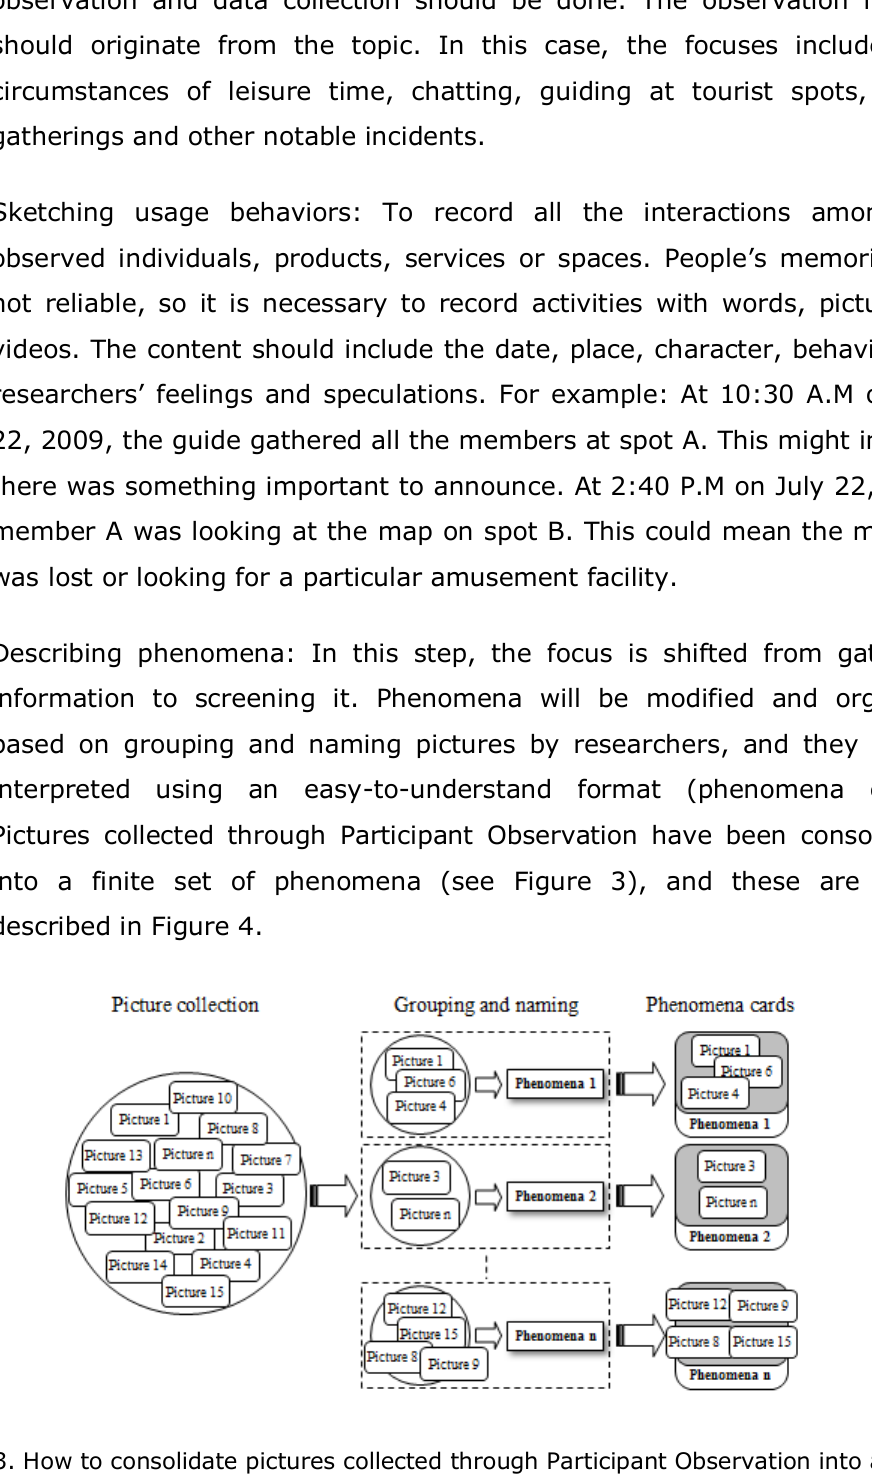
Figure 3. How to consolidate pictures collected through Participant Observation into a finite set of